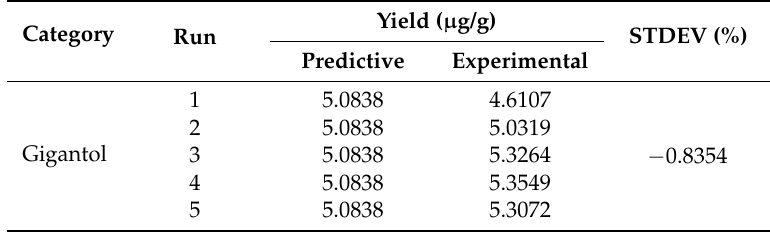
Table 5. Verification of the experimental